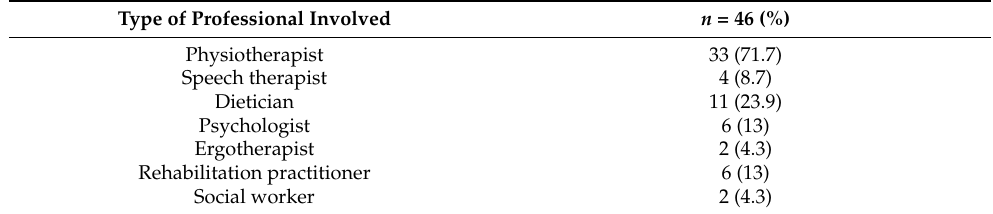
Table A2. Inventory of professionals involved in the individual care plans of the post-ICU patients